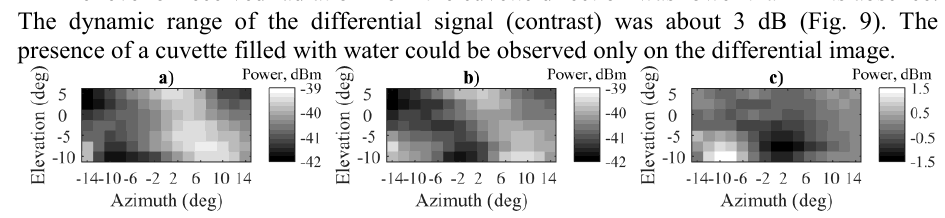
Fig. 9. Images of a cuvette filled with water in a radiolight: a) a background image (there is no cuvette), b) an image with a cuvette, c) a differential